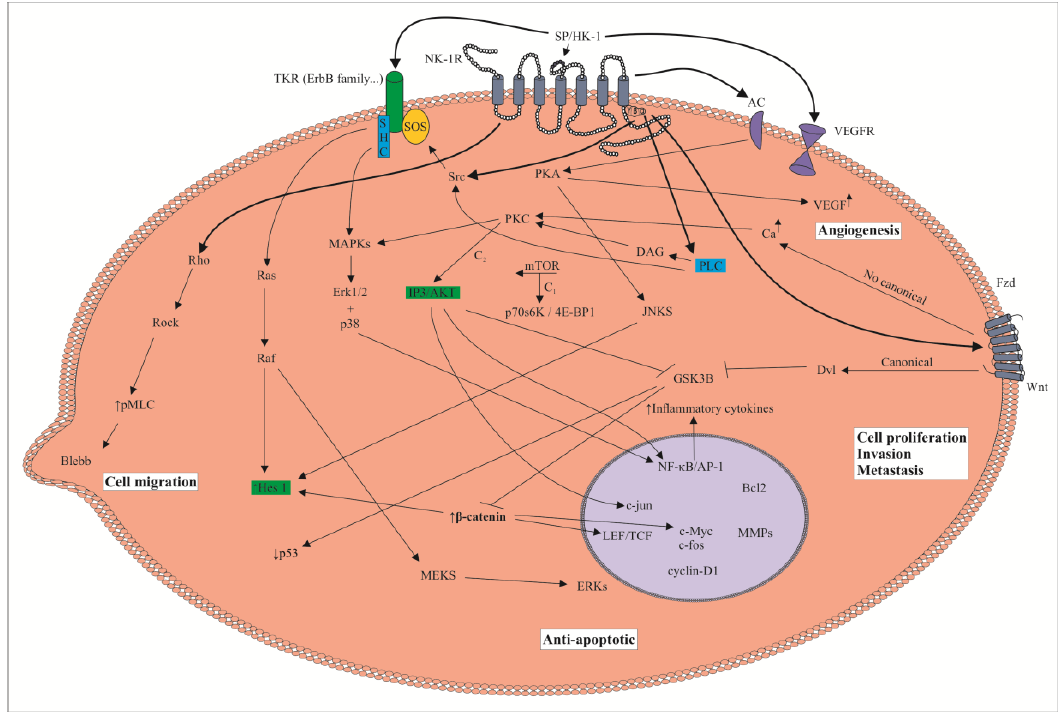
Figure 1. Tumor cell: signaling pathways downstream of the neurokinin-1 receptor (NK-1R). Substance P (SP), after binding to the NK-1R, promotes tumor cell proliferation and migration and an anti-apoptotic effect. In endothelial cells, SP via the NK-1R favors angiogenesis. NK-1R antagonists block these pathways and inhibit the effects mediated by SP on tumor and endothelial cells. 4E-BP 1: eukaryotic initiation factor 4E-binding protein 1; AC: adenylyl cyclase; AKT: protein kinase B; DAG: